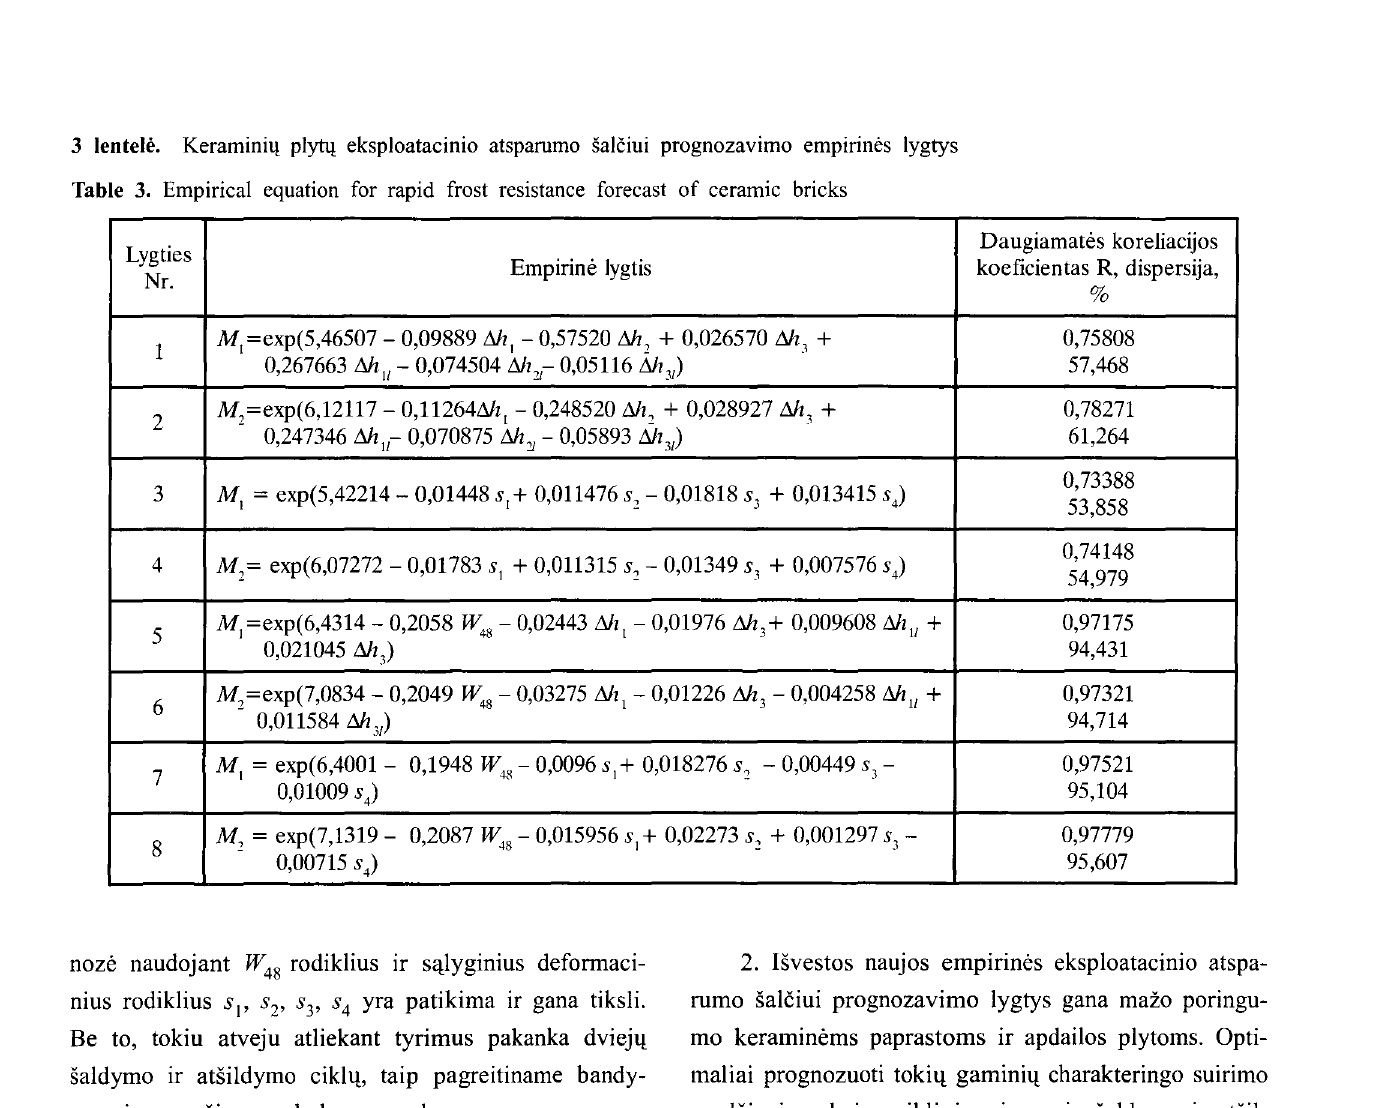
Daugiamates koreliacijos